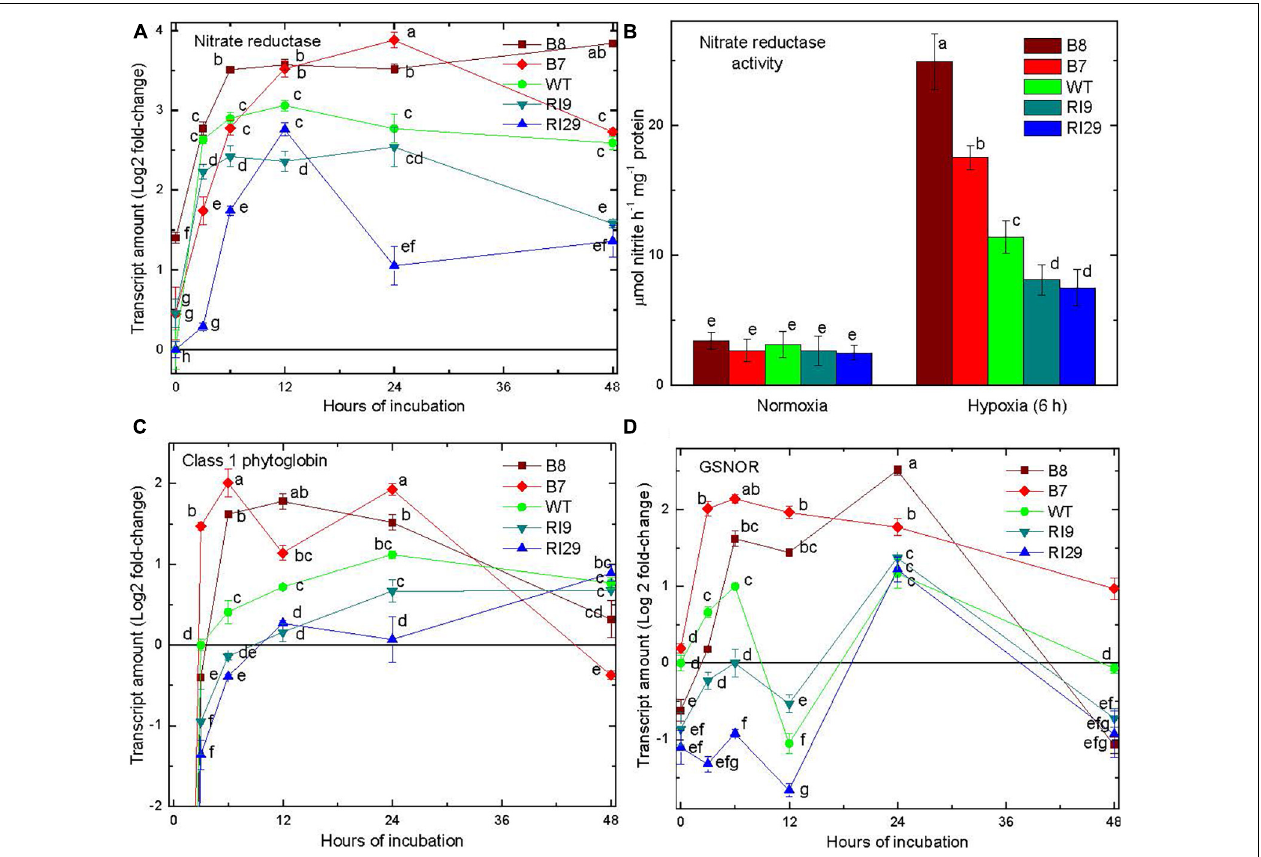
FIGURE 2 | Leaf nitrate reductase transcript amount (A) , nitrate reductase activity (B) , class 1 phytoglobin transcript amount (C) , and S -nitrosoglutathione reductase transcript amount (D) in tobacco plants with variable amounts of alternative oxidase, and exposed to hypoxia (at time 0 in A,C,D) . In (C) , there was no detectable transcript at time 0. Vertical bars indicate SD from three independent experiments ( n = 3); different letters indicate significant differences between five tobacco lines and the time points.